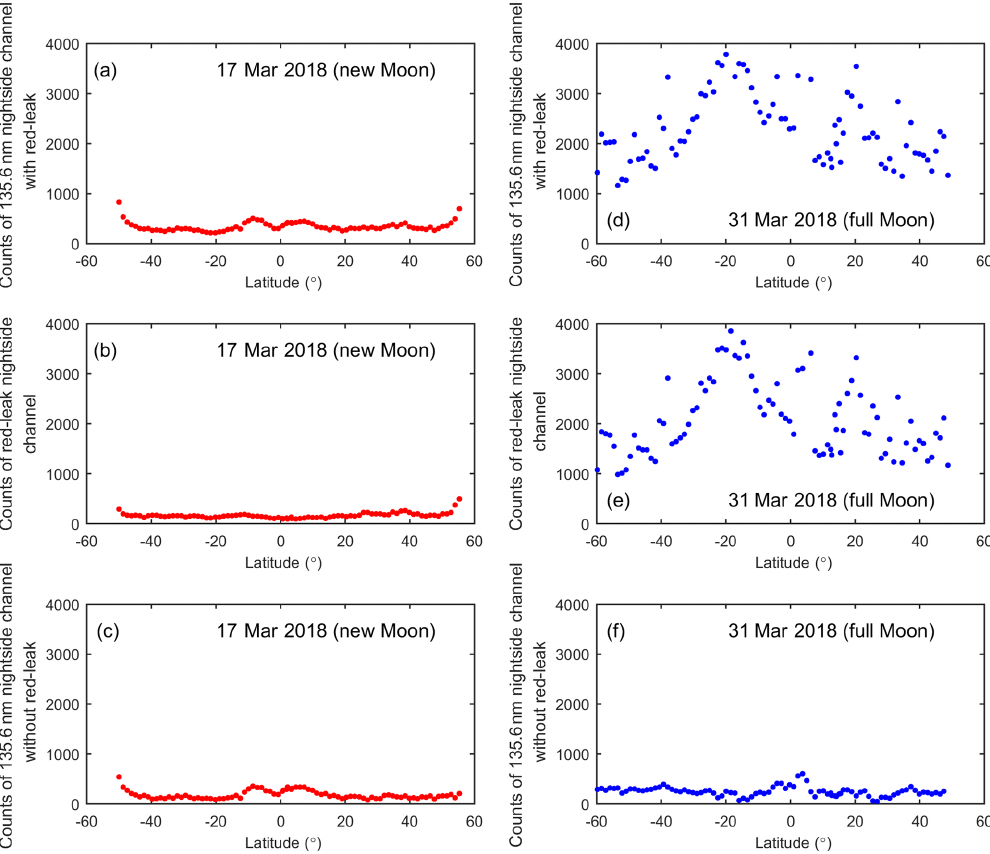
Figure 6. The count of the 135.6nm nightside channel with red leak (a, d) , without red leak (c, f) , and the count of the red-leak nightside channel (b, e) . 17 March 2018 is the new moon day, and 31 March 2018 is full moon day.